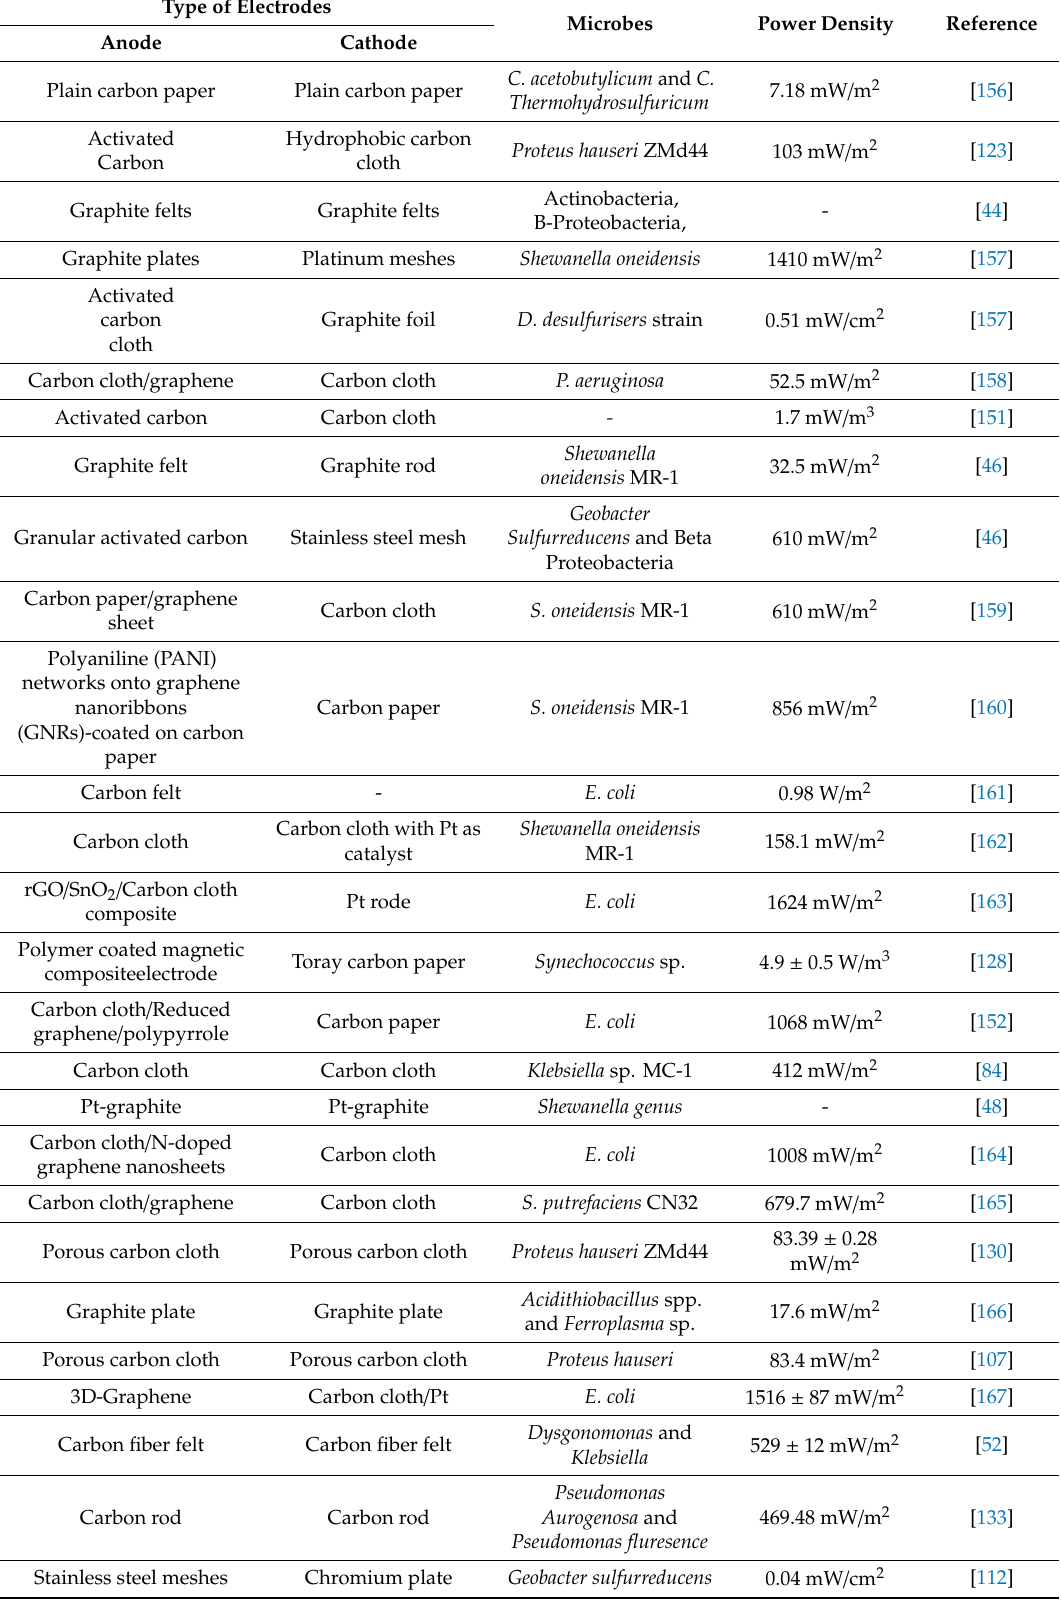
Table 3. List of electrodes and microbes with energy output through